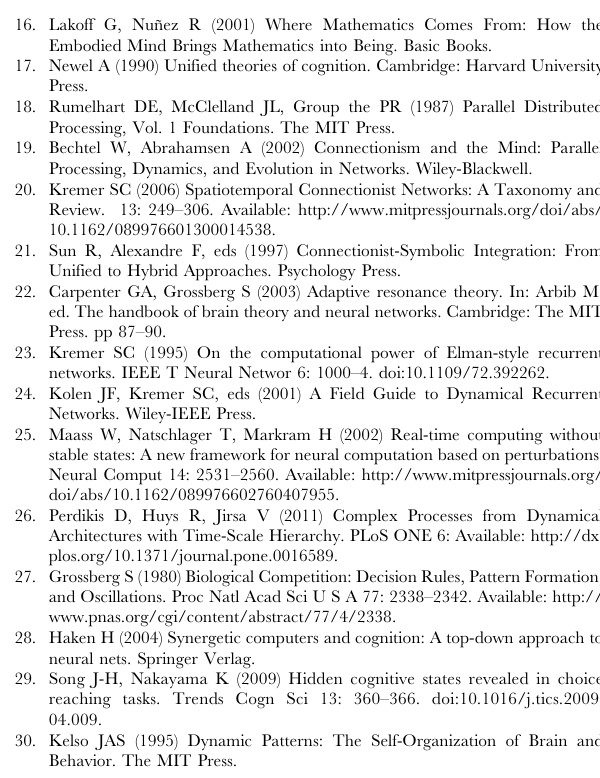
Table S1 Parameters of functional modes’ phase